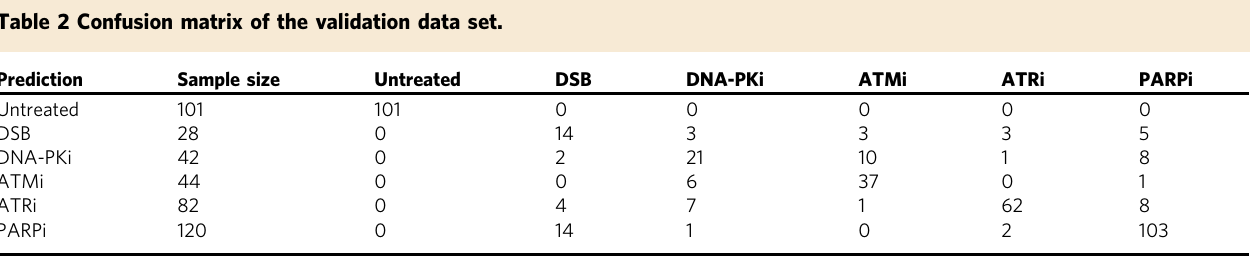
Table 2 Confusion matrix of the validation data set.